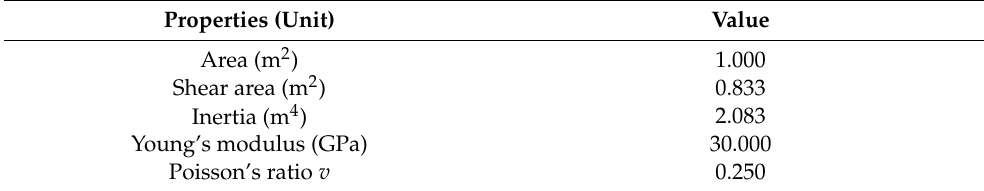
Table 1. Properties of the FEM of the simply supported